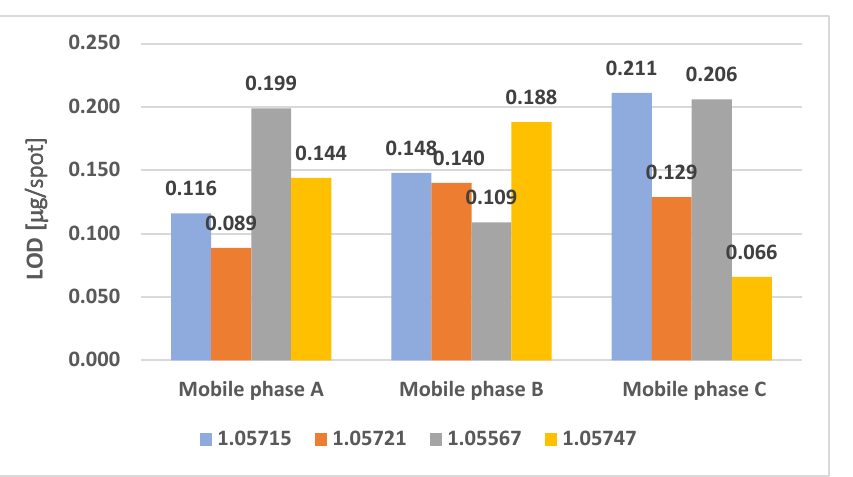
Figure 2. Mean values of the limit of detection of fluoxetine obtained by adsorption thin-layer chromatography, where the mobile phases were as follows: A—chloroform + methanol + ammonia, 9:1:0.4 ( v/v/v ); B—chloroform + methanol + glacial acetic acid, 5:4:1 ( v/v/v ); C—acetone + toluene + ammonia, 10:9:1 ( v/v/v ). The chromatographic plates were: 1.05715—silica gel 60 F 254 on glass